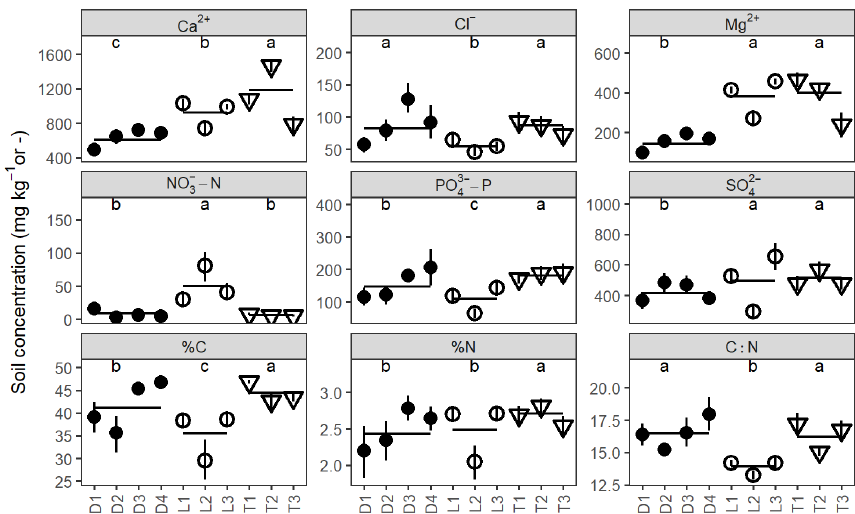
Figure 5. Average soil extraction concentrations for every site and solute analyzed. Shapes correspond with site hydrogeomorphic type; vertical bars indicate bootstrapped 95% confidence intervals about the mean for each site, and horizontal bars indicate means within groups. Significantly different groups at p = 0 . 05 are labeled with letters. Note: %C, %N, and C:N are unitless (–) and are determined from combustion, not soil extraction.